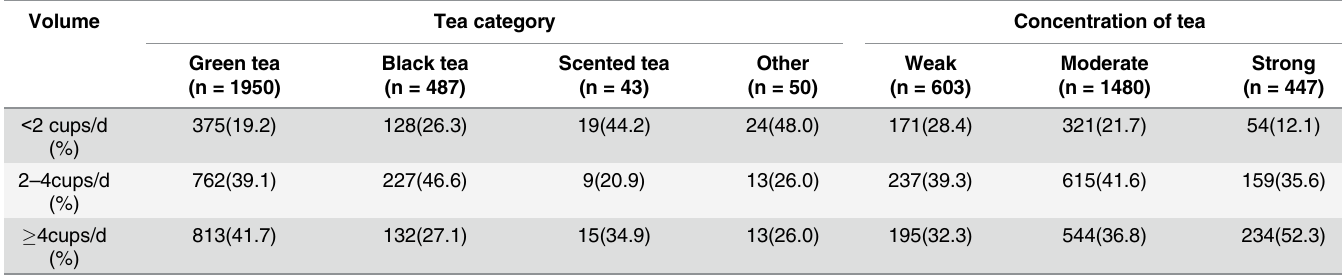
Table 1. Frequency of tea consumption among study